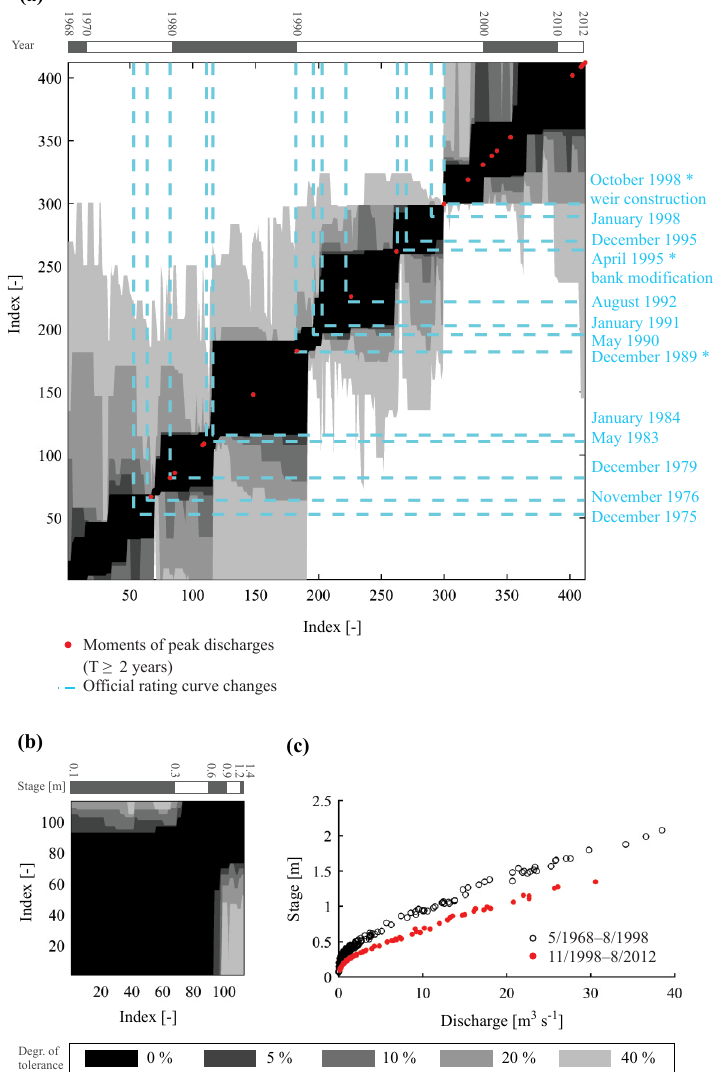
Figure 3. (a) Combined BReach t_2s plot (all data) and (b) combined BReach h_1s plot (data between November 1998 and August 2012) for Taw Bridge. In all subplots, for each index on the x axis the gray area indicates the span between the index of the maximum left reach (under the bisector) and the maximum right reach (above the bisector). Each gray tint represents a different degree of tolerance (i.e., percentage of data points allowed to have nonacceptable model results). (c) Stage–discharge data for Taw